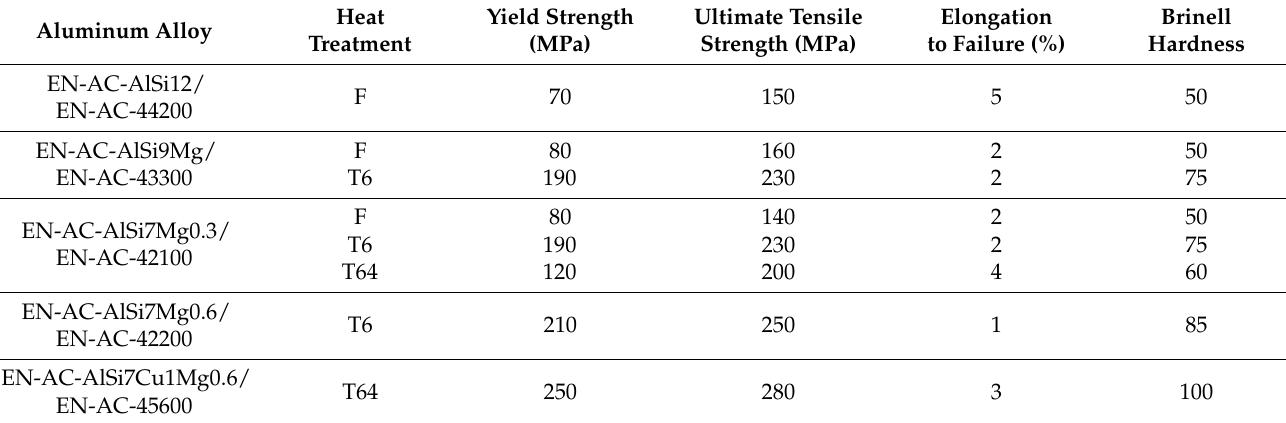
Table 1. Selection of aluminum casting alloys and their mechanical properties